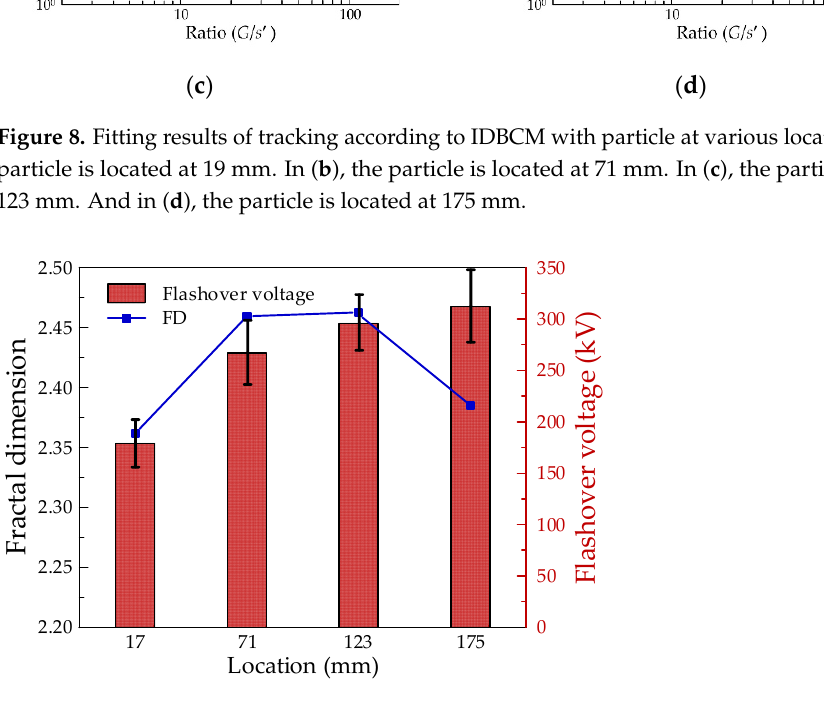
Figure 9. Fractal dimension of tracking and corresponding flashover voltage of EP sample with particle at various locations.